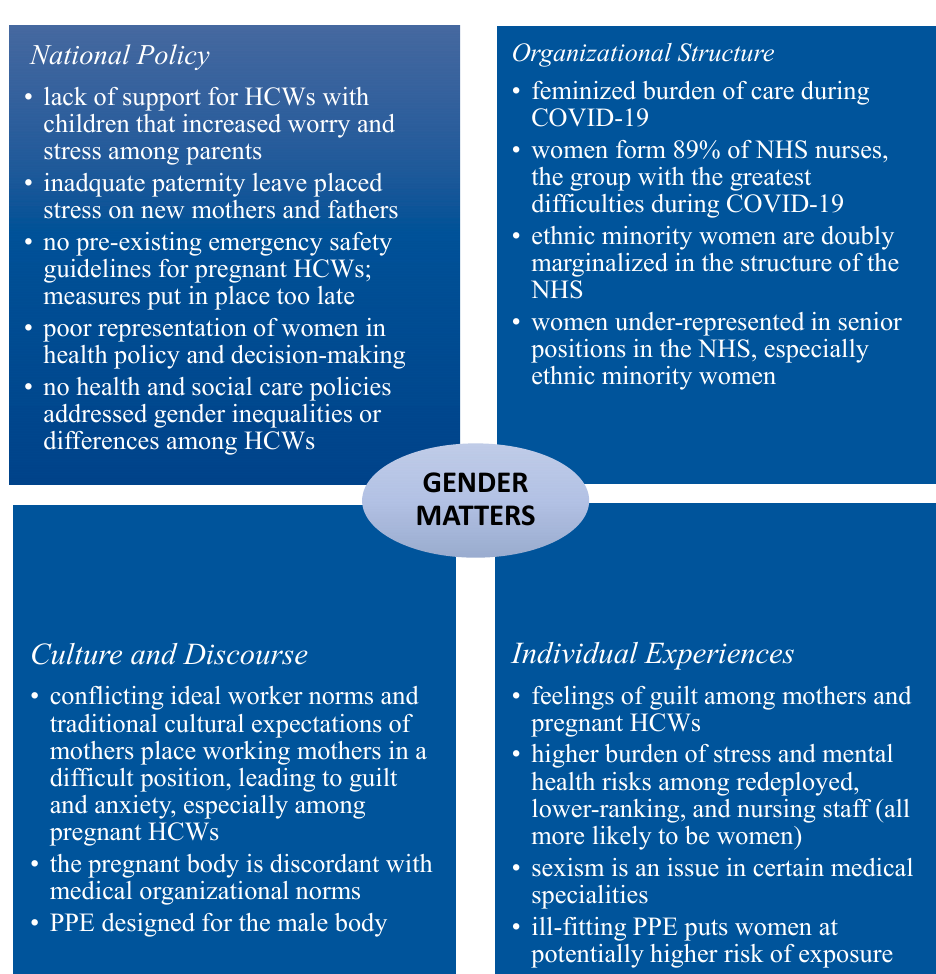
Figure 1. Gender Matters: summary of